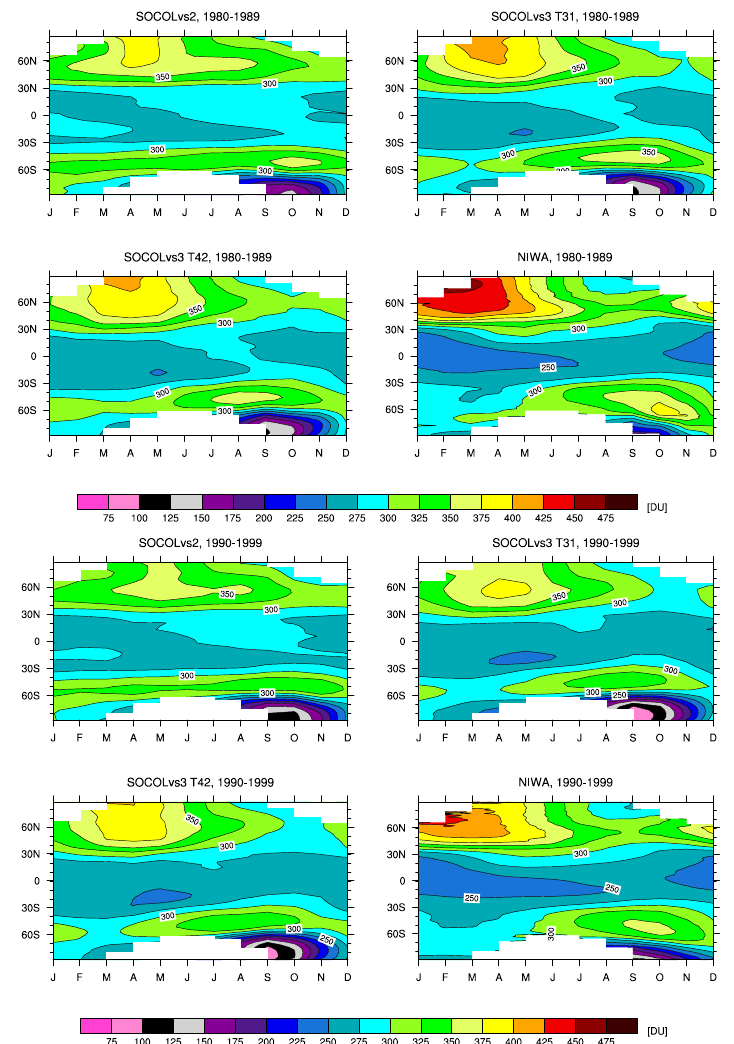
Fig. 11. Zonal mean of total ozone in DU averaged over the two 10yr periods, 1980–1989 (upper four panel) and 1990–1999 (lower four panel), for SOCOLvs2, SOCOLvs3 in T31 and T42 horizontal resolution, and NIWA observational